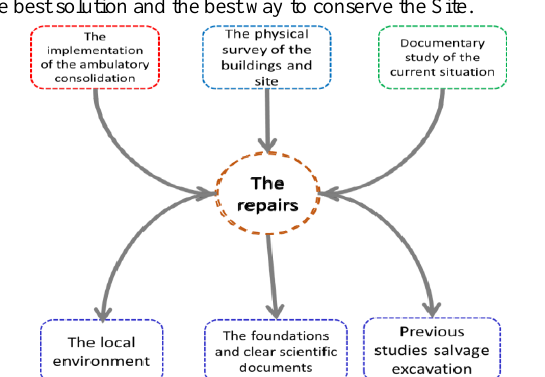
Figure(34)Shema of the sestamfffatic of the work documentation and damage assessment